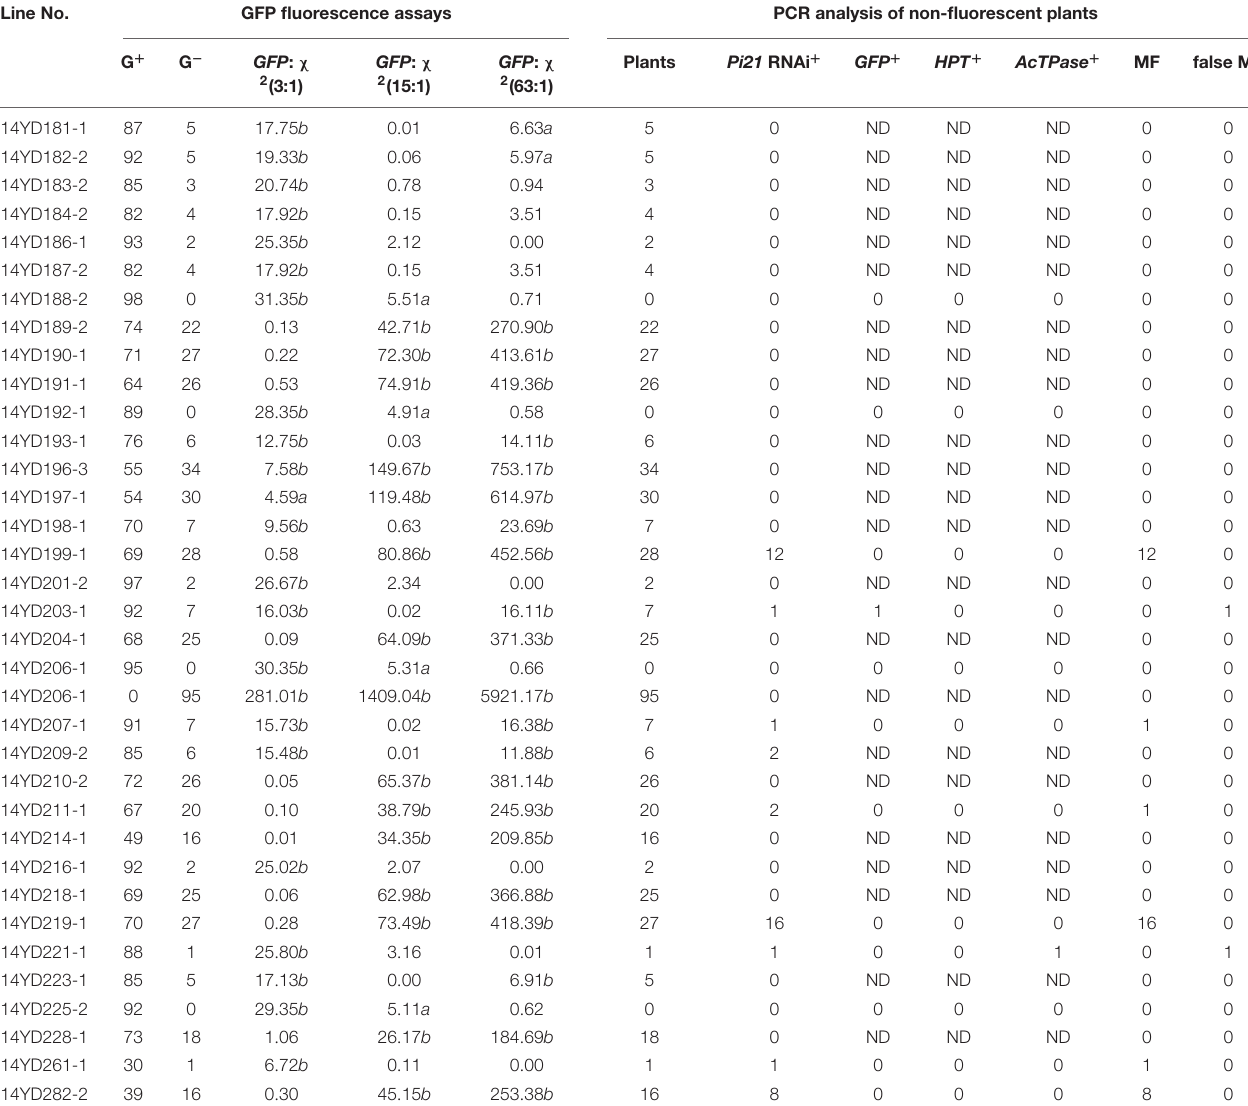
TABLE 3 | Fluorescence assays and PCR analysis of T1 transgenic rice plants transformed with pBDL22. Line No. GFP fluorescence assays PCR analysis of non-fluorescent